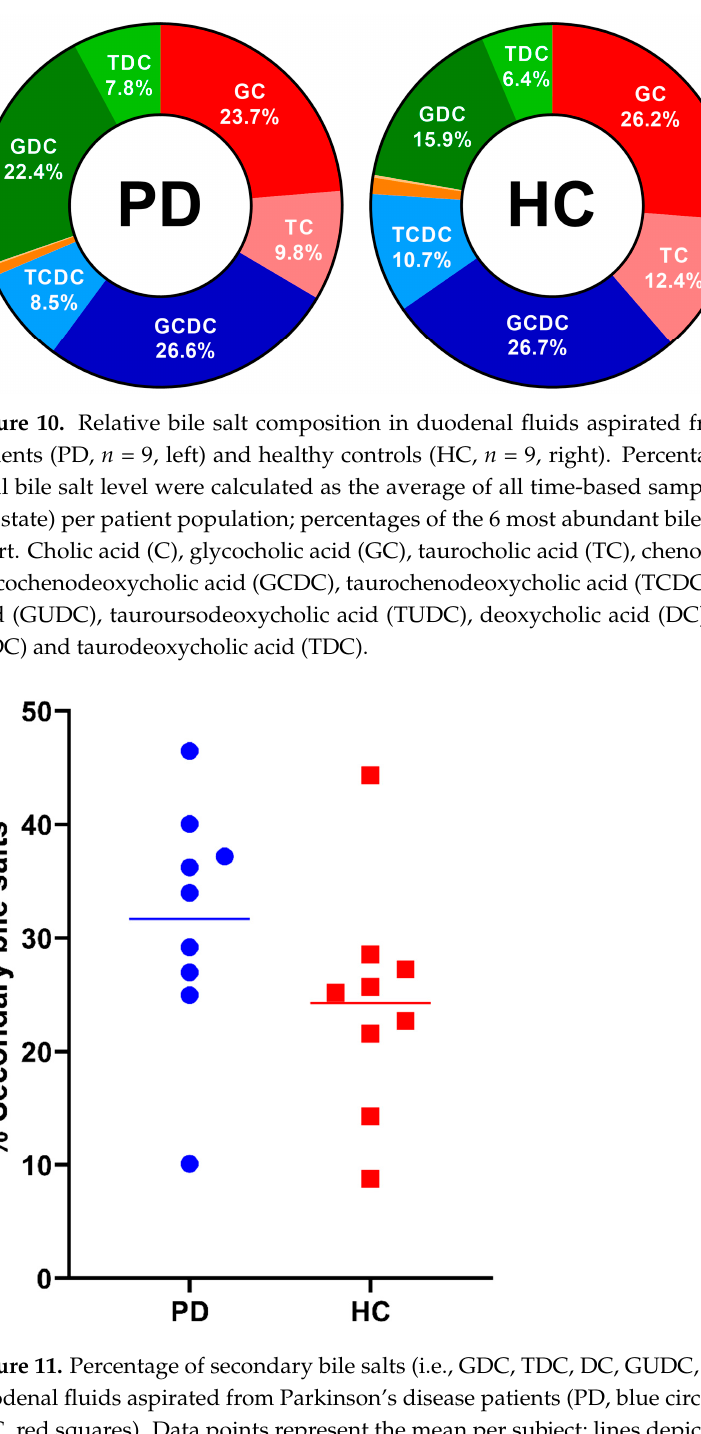
Figure 9. Time-dependent evolution of the total bile salt concentration in duodenal fluids aspirated from Parkinson’s disease patients ( n = 9, blue circles) and healthy controls ( n = 9, red squares). Data points represent the mean ± standard deviation; vertical dotted lines indicate the ingestion of 100 mL of water or 200 mL of liquid meal.